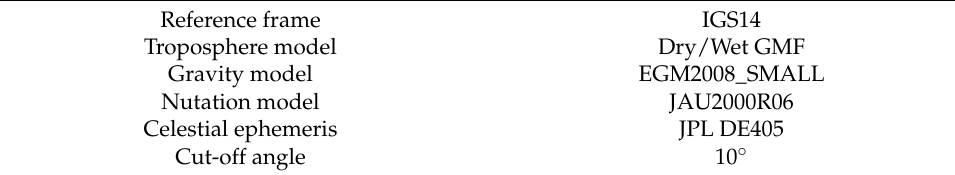
Table 3. Option of the Bernese Software